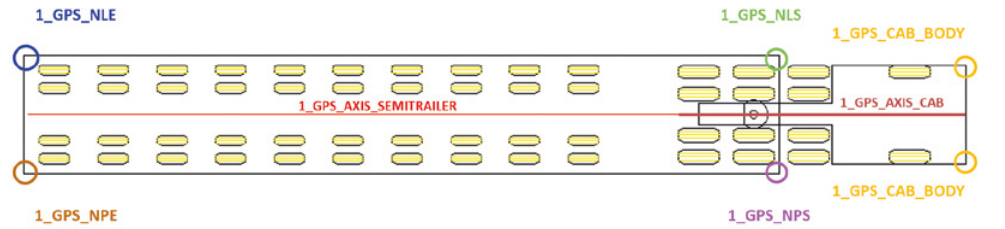
Figure 3. Differentiation of points by the position on the